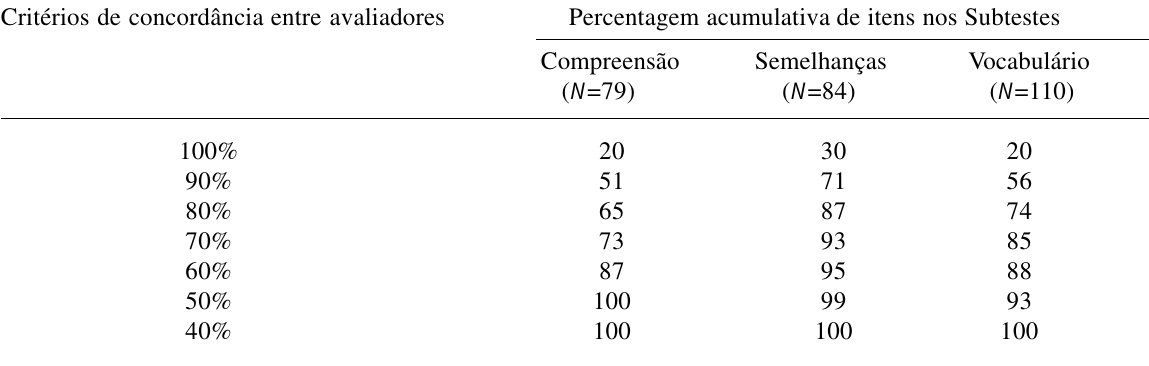
Percentagem Acumulativa de Itens Com a Mesma Pontuação e os Diferentes Critérios de Concordância Critérios de concordância entre